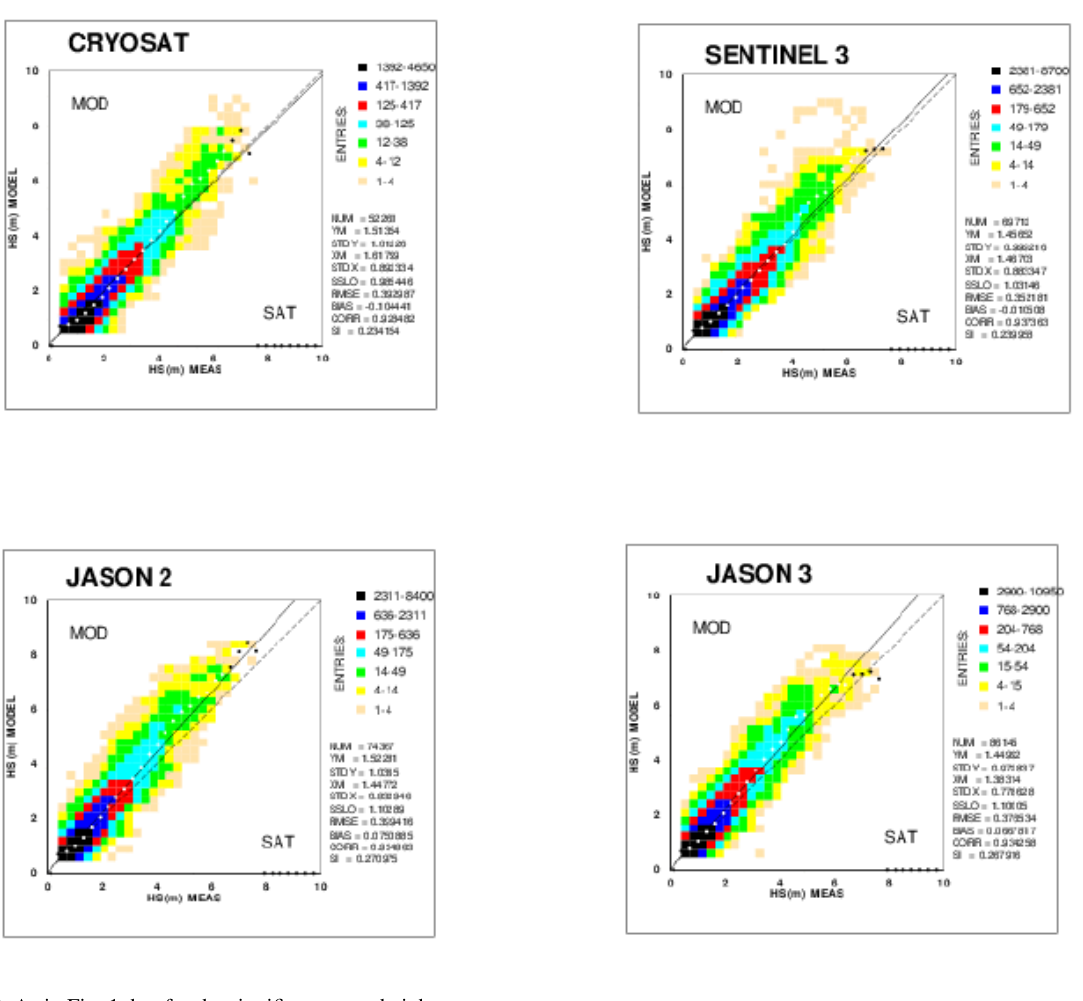
Figure 2. As in Fig. 1, but for the significant wave height.